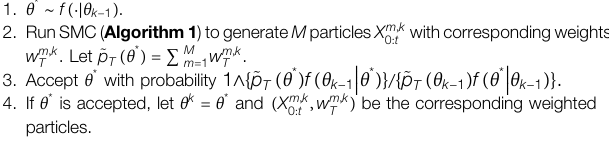
Algorithm 2 | PMCMC at the k th iteration, initialized with θ 0 ∼ f